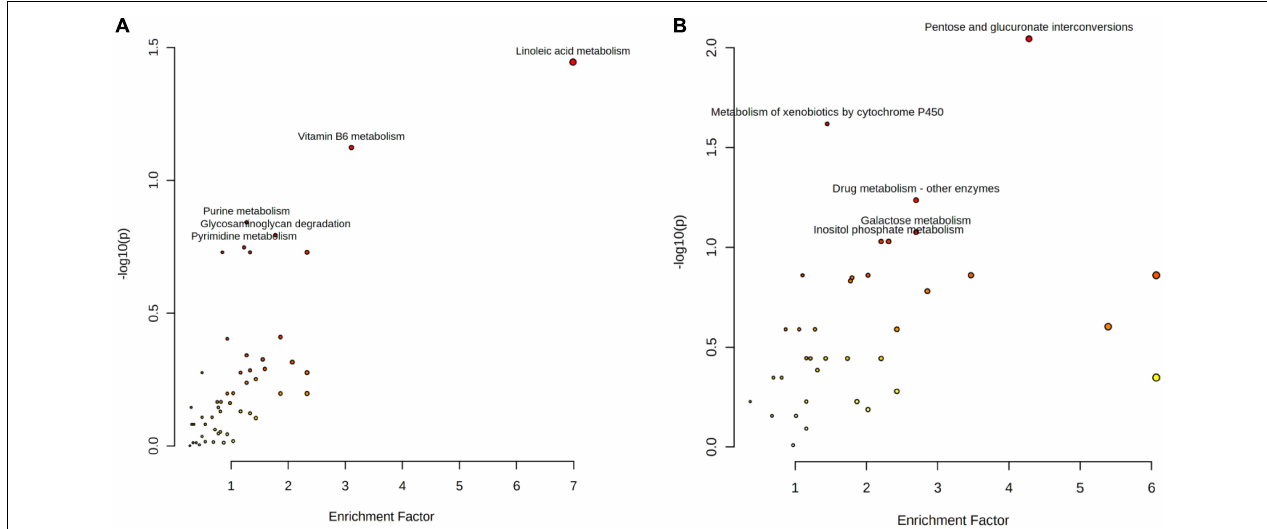
FIGURE 1 | The metabolome view map of significant metabolic pathways identified in buffalo and cow milk. (A) Positive ionization modes; (B) negative ionization modes.